Question: Summarize what this figure shows in one sentence.
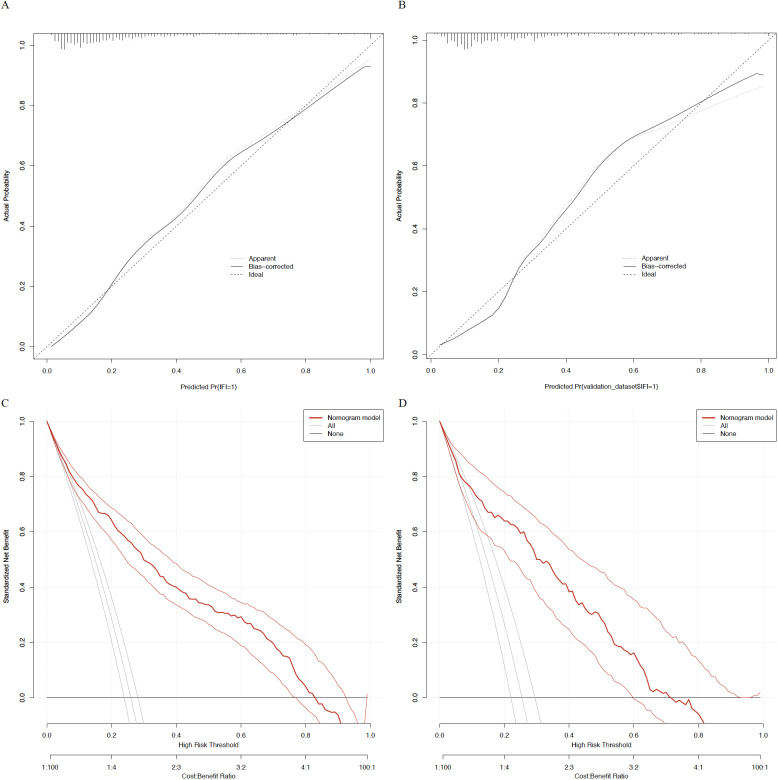
Answer: Evaluation of model calibration and clinical utility for the IFI prediction nomogram. (A, B) Calibration curves depict the concordance between predicted probabilities and actual outcomes. The diagonal dashed line represents the ideal calibration. (C, D) Decision curve analysis (DCA) estimates the net benefit of using the nomogram for clinical decision-making against different intervention thresholds.